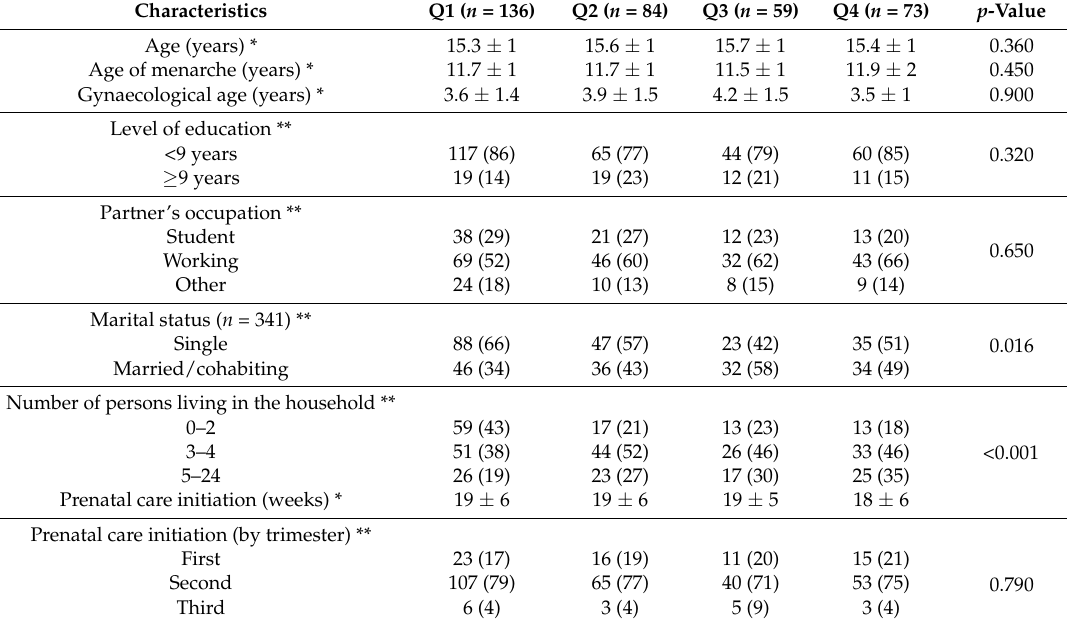
Table 1. General characteristics of the pregnant adolescents according to family support network quartile ( n =